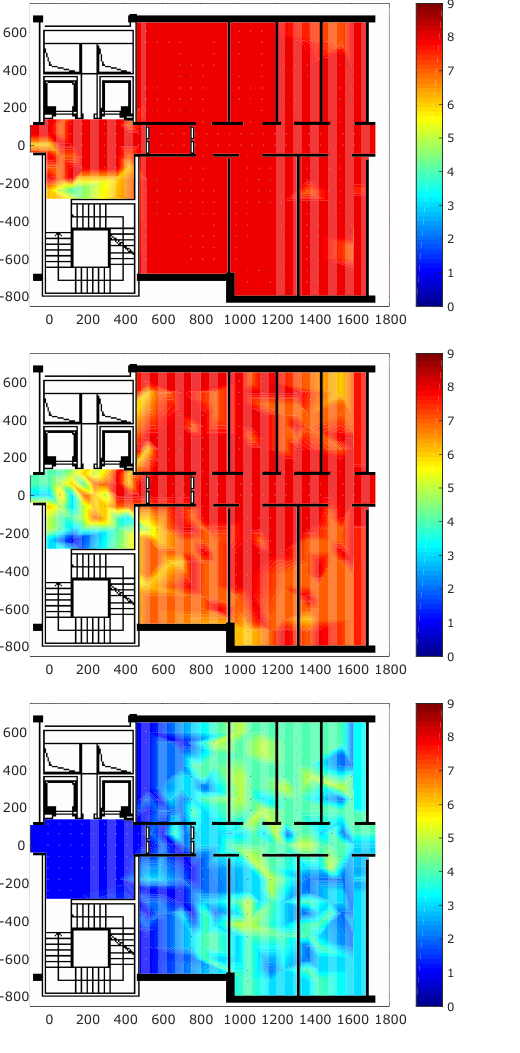
Figure 4. Coverage representation for the remote positioning ( left ) and self positioning configurations ( right ). From the top to bottom, the transmission power values are 3 dBm, − 6 dBm, and − 18